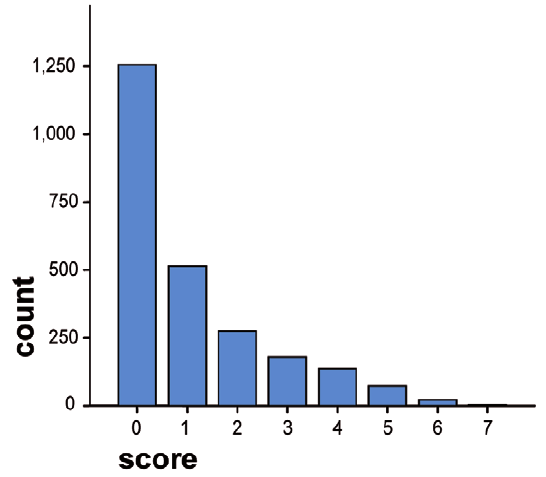
Figure 1. Distribution of scores on the screening tool on all prisoners screened